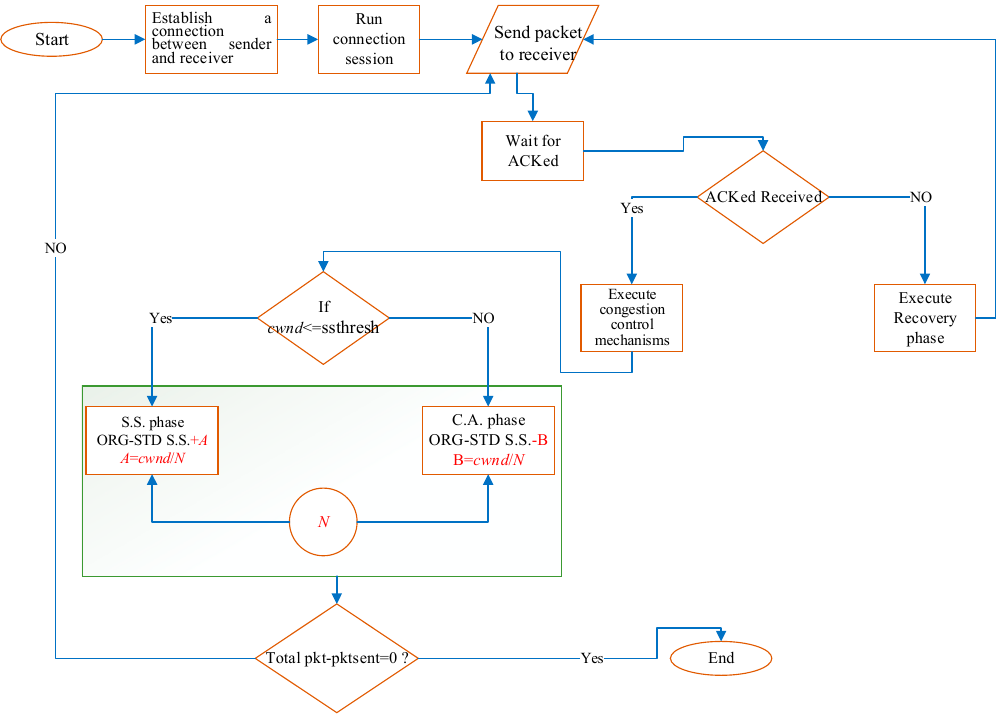
Figure 2. Flowchart of the proposed congestion control mechanism. ACKed: acknowledgement;